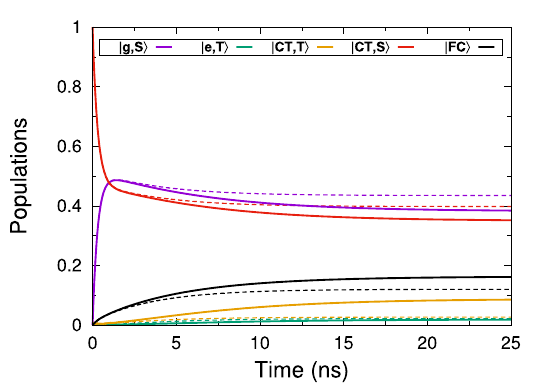
Figure 2. Schematic representation of the basic energy levels involved in the process of photocurrent generation in an OPV. Incoming photons create singlet exciton states, which rapidly evolve to become singlet charge transfer states. Inter-system crossing –represented here by solid arrows– can transform these singlet states into triplet CTs, that are Zeeman split by an external magnetic field. From charge transfer states, either the e–h pair recombines to the ground state or dissociation takes place and a free charge is generated, in incoherent processes represented by dotted arrows whose relative strength represents the characteristic rates for the corresponding transitions. An abstract load between the free charge and the ground state allows to study the I–V characteristics of the model.